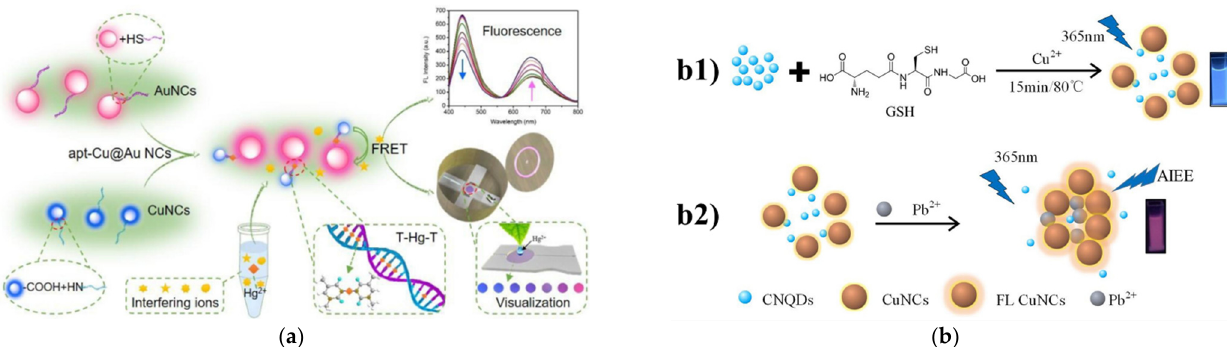
Figure 4. ( a ) Schematic of apt-Cu@Au NCs aptasensor for Hg 2+ ions detection; ( b ) (b1) Schematic of the preparation of CuNCs–CNQDs nanohybrid; (b2) Schematic for the Pb 2+ detection assay.